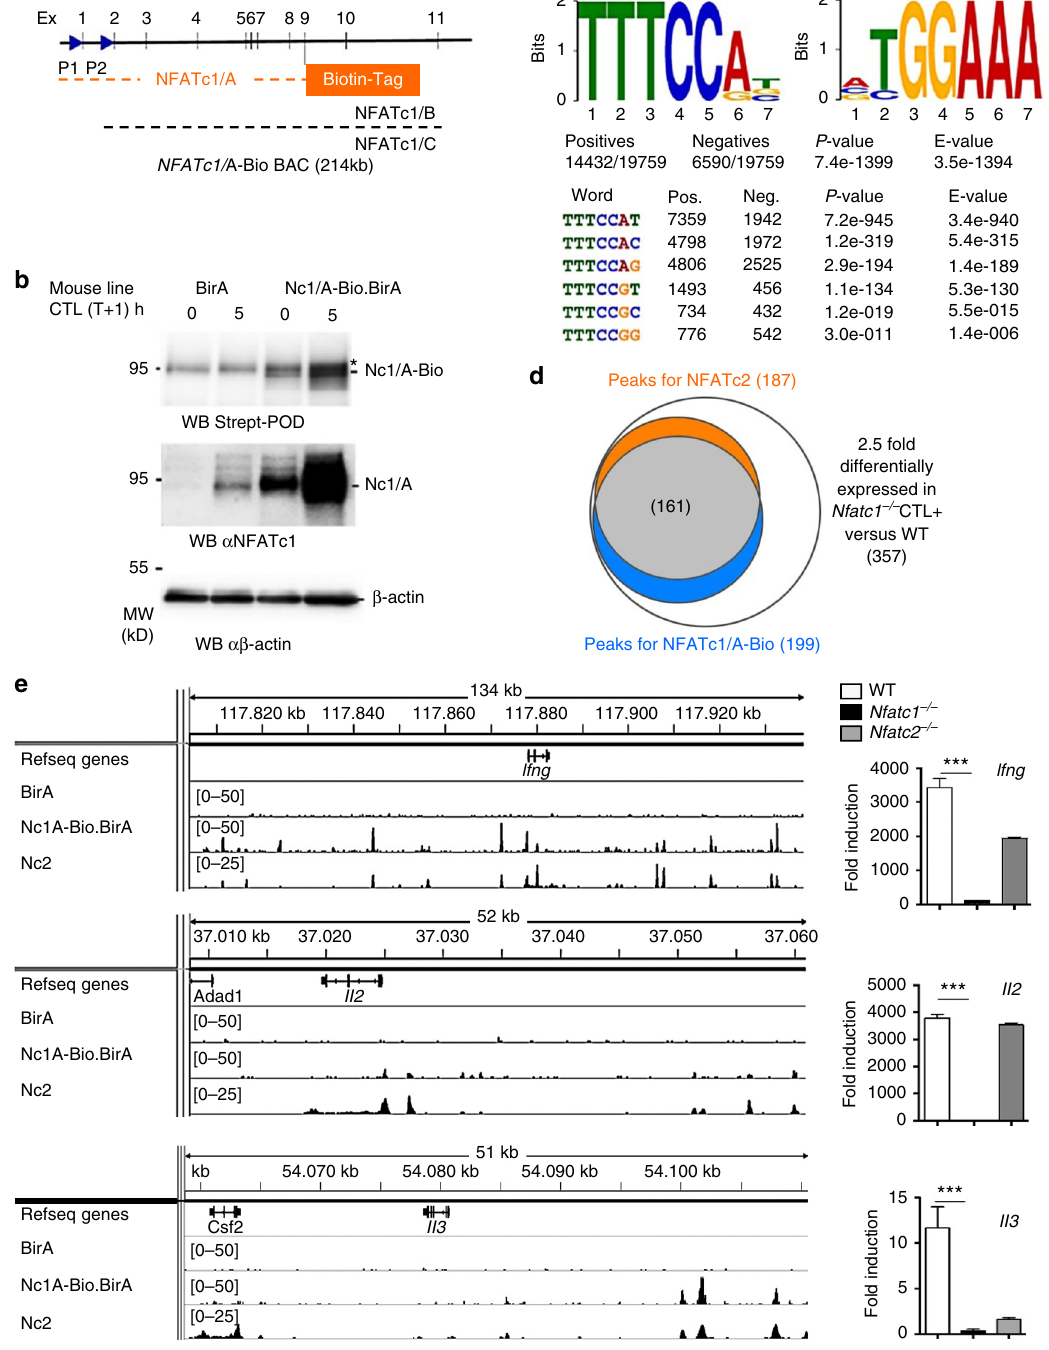
Fig. 5 Analysis of DNA binding of NFATc1/A-Bio in CTLs by ChIP seq assays. a Scheme of the Nfatc1 BAC transgene expressing tagged NFATc1/A-Bio protein in mice. The two promoters P1 and P2 and the 11 exons of the gene are indicated. b Immune blots of whole cell protein extracts from CTLs expressing only the E. coli biotin-ligase BirA, or BirA and NFATc1/A-Bio. The upper blot was incubated with an Ab directed against streptavidin, the lower blot with the NFATc1-speci fi c mAb 7A6.The star indicates a non-speci fi c band. c Motif analysis of NFATc1 binding sites in the 19 759 NFATc1/A peaks identi fi ed with a p -value of − 5 by MACS. The letter size indicates the frequency of nucleotides within those sites (presented as ‘ Bits ’ ). d Peaks for NFATc1/A-Bio and NFATc2 19 ( p -value of − 12 in MACS) within a distance of 100 kb to the 357 genes that were 2.5-fold differentially expressed in Nfatc1 − / − ( Nfatc1 f/f x CD4-cre mice), compared to WT CTLs. 161 genes show both NFATc1/A-Bio and NFATc2 binding. e Binding of NFATc1/A-Bio and NFATc2 19 to the prototypical NFAT target genes Ifng , Il2 and Il3 in CTLs + . Right , real-time PCR assays of Ifng , Il2 and Il3 RNA levels in WT, Nfatc1 − / − and Nfatc2 − / − CTL + cells, normalized by Actb and relative to naïve CD8 + T